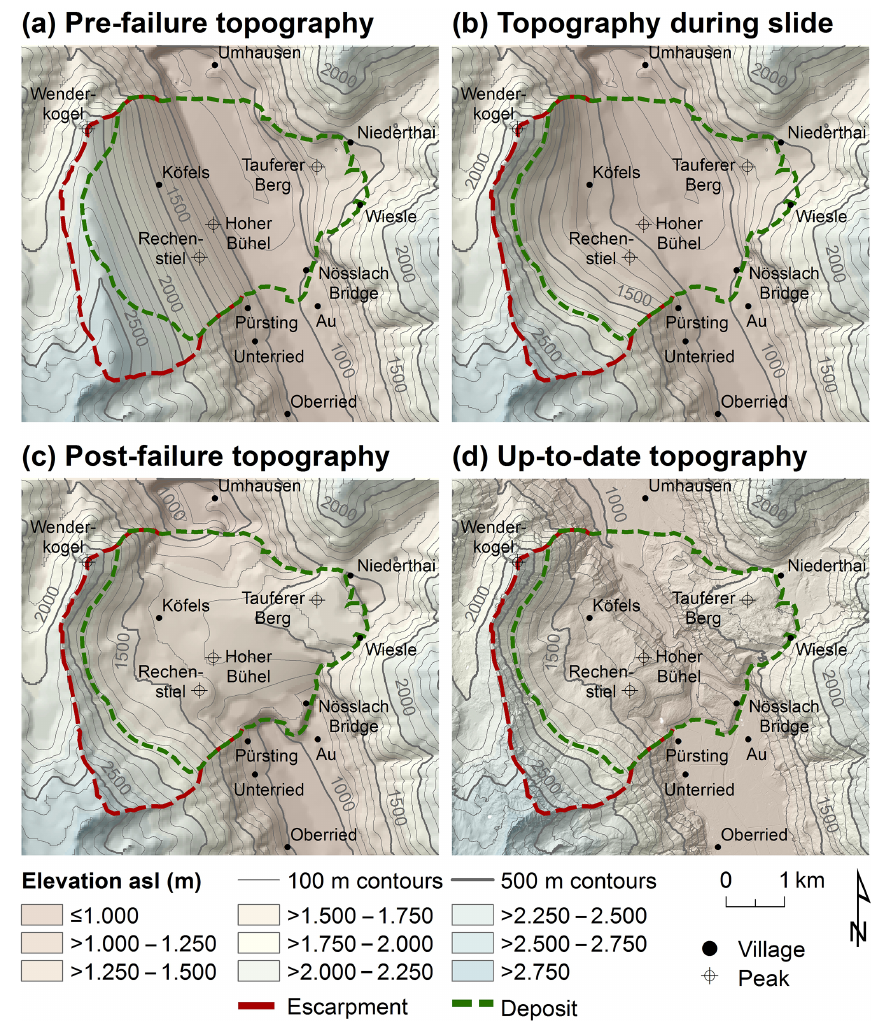
Figure 6. DEM of the three reconstructed stages and the up-to-date topography: (a) pre-failure, (b) bedrock, (c) post-failure and (d) up-to- date. The spatial resolution of the DEMs is 30m in (a–c) and 1m in (d)